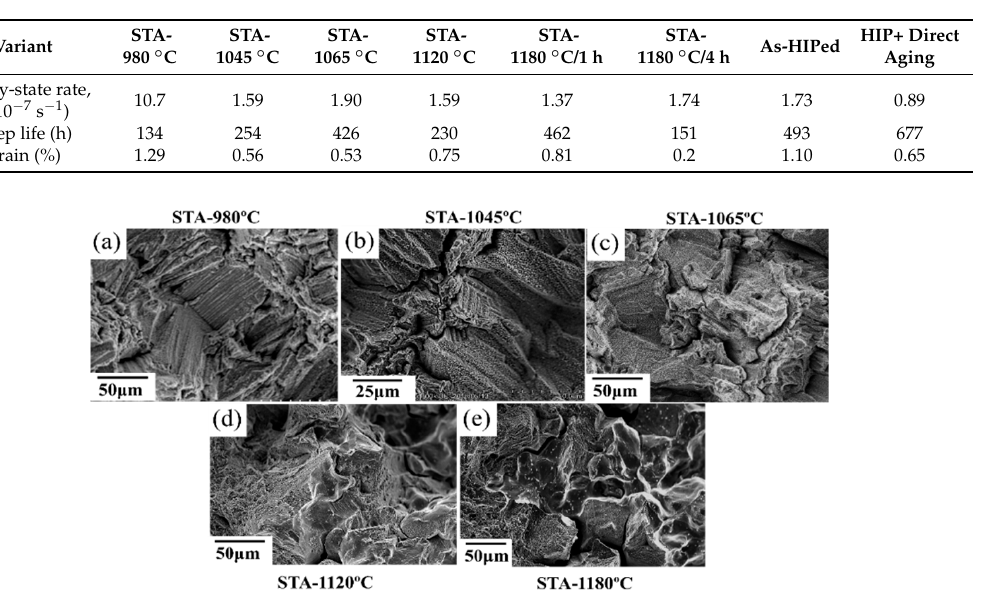
Figure 10. ( a ) Creep life, ( b ) creep rupture elongation, and ( c ) the minimum creep rate of heat-treated specimens under 650 ◦ C and 550 MPa. Table 5. Creep properties of post-processed specimens.